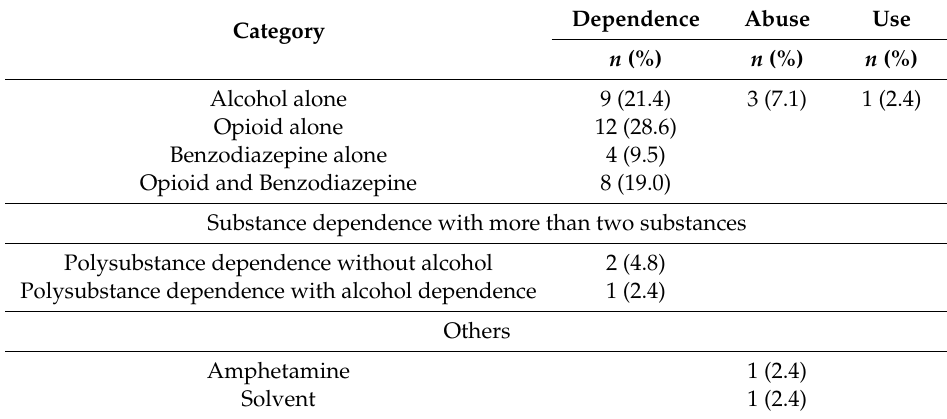
Table 2. Represents the percentage of subjects using various drugs (based on